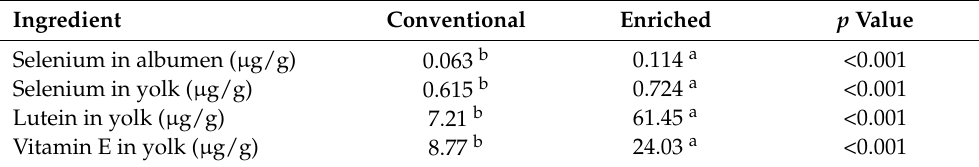
Table 6. Content of selenium, vitamin E, and lutein in